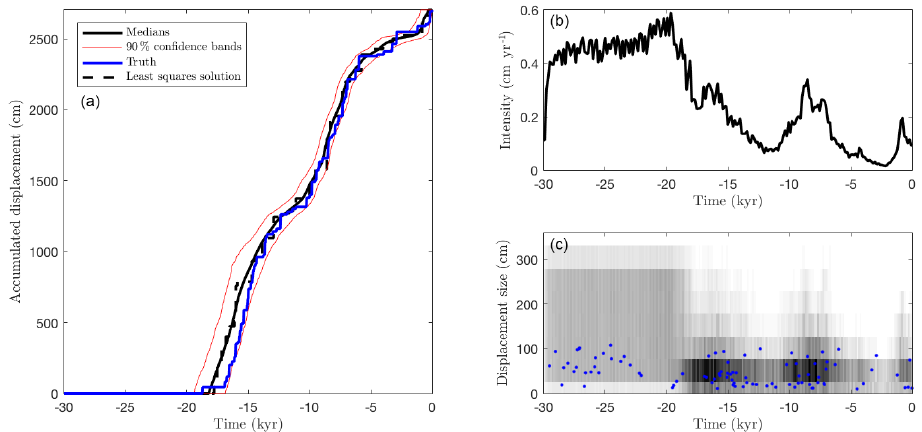
Figure 4. The synthetic case with 146 36 Cl measurements: the accumulated displacement (a) , the mean earthquake intensity (b) , and an event scatter plot (c) showing true events (blue) and events from posterior samples (with gray scale to indicate frequencies).